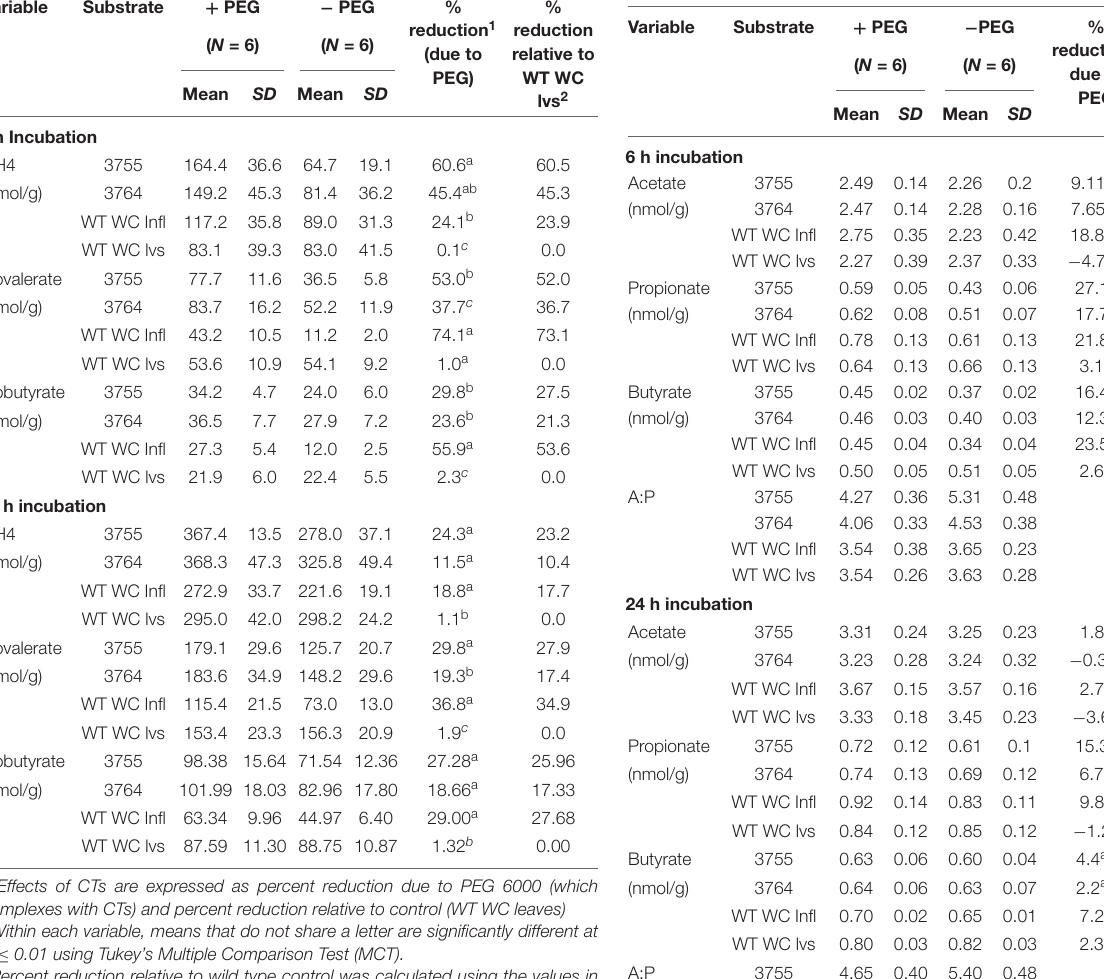
TABLE 2 | Production of predominant short chain fatty acids (SCFA) after 6 h and 24 h of incubation in rumen fluid with and without polyethylene glycol 6000 (PEG) in vitro §